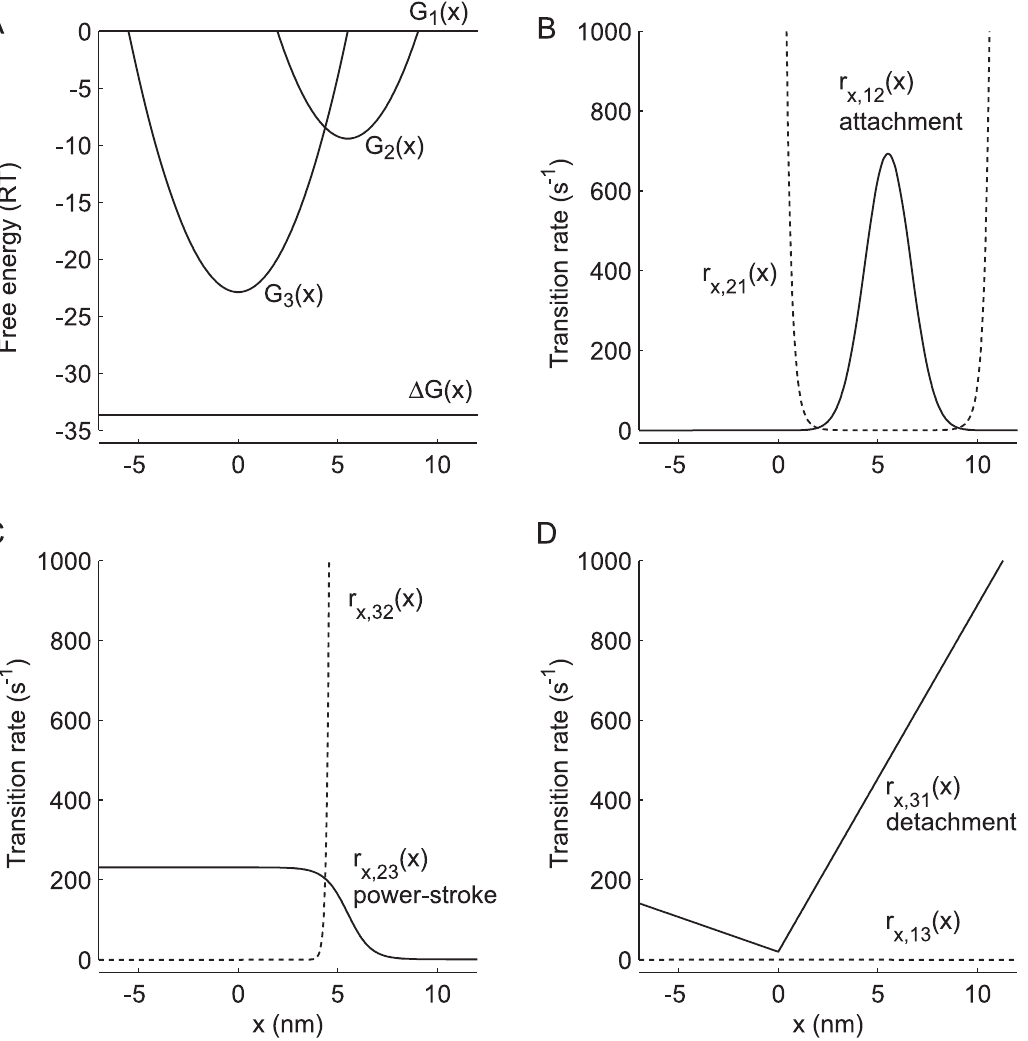
Figure 6. Position dependent XB kinetics for k xb =3 pN nm 2 1 . Position-dependent free energy differences (A) and transition rates (B–D) for the XB states illustrated in Figure 1A are plotted against, x, which represents the position difference between a particular pair of actin and myosin nodes supporting a bound XB. (A) The top horizontal line shows the free energy of the detached state (G 1 (x)), where the difference between the two horizontal lines represents the standard free energy drop over a full XB cycle ( D G(x)). Each parabolic free energy well G 2 (x) and G 3 (x) represents bound states XB2 and XB3, respectively. For panels B–D, solid lines represent forward transition rates, and dashed lines represent reverse transition rates as formulated in Tanner et al. [27]. Figure S4, we ran a number of preliminary simulations over an extensive range of Y values and a near-exhaustive set of potential source-target combinations. Based on these findings we focused